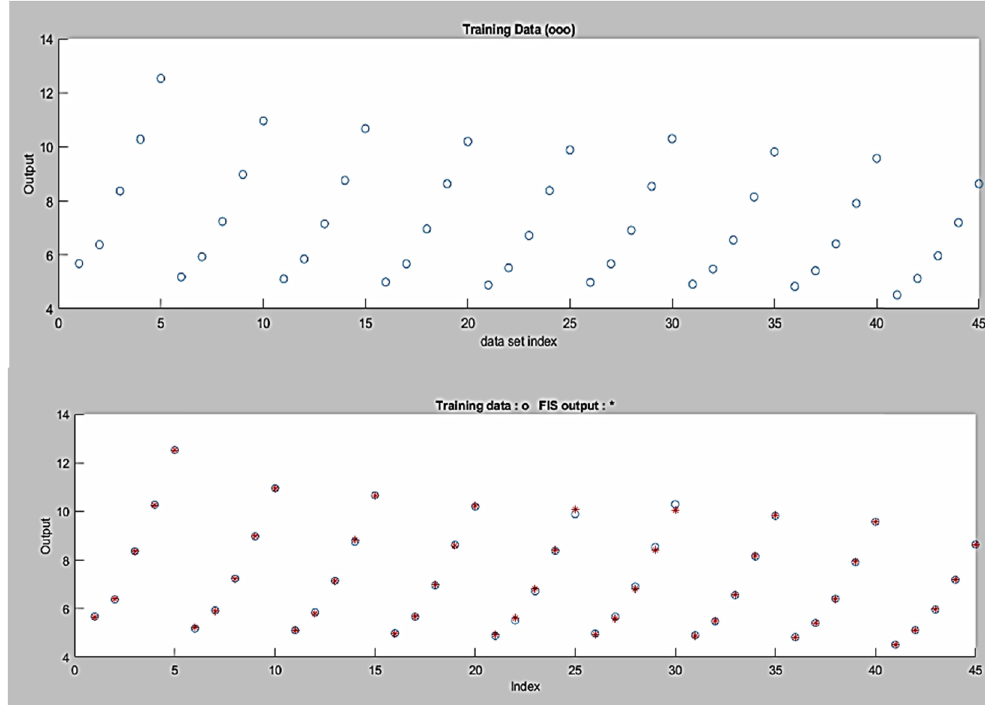
Figure 6: The output results of the ANFIS model compared with experimental